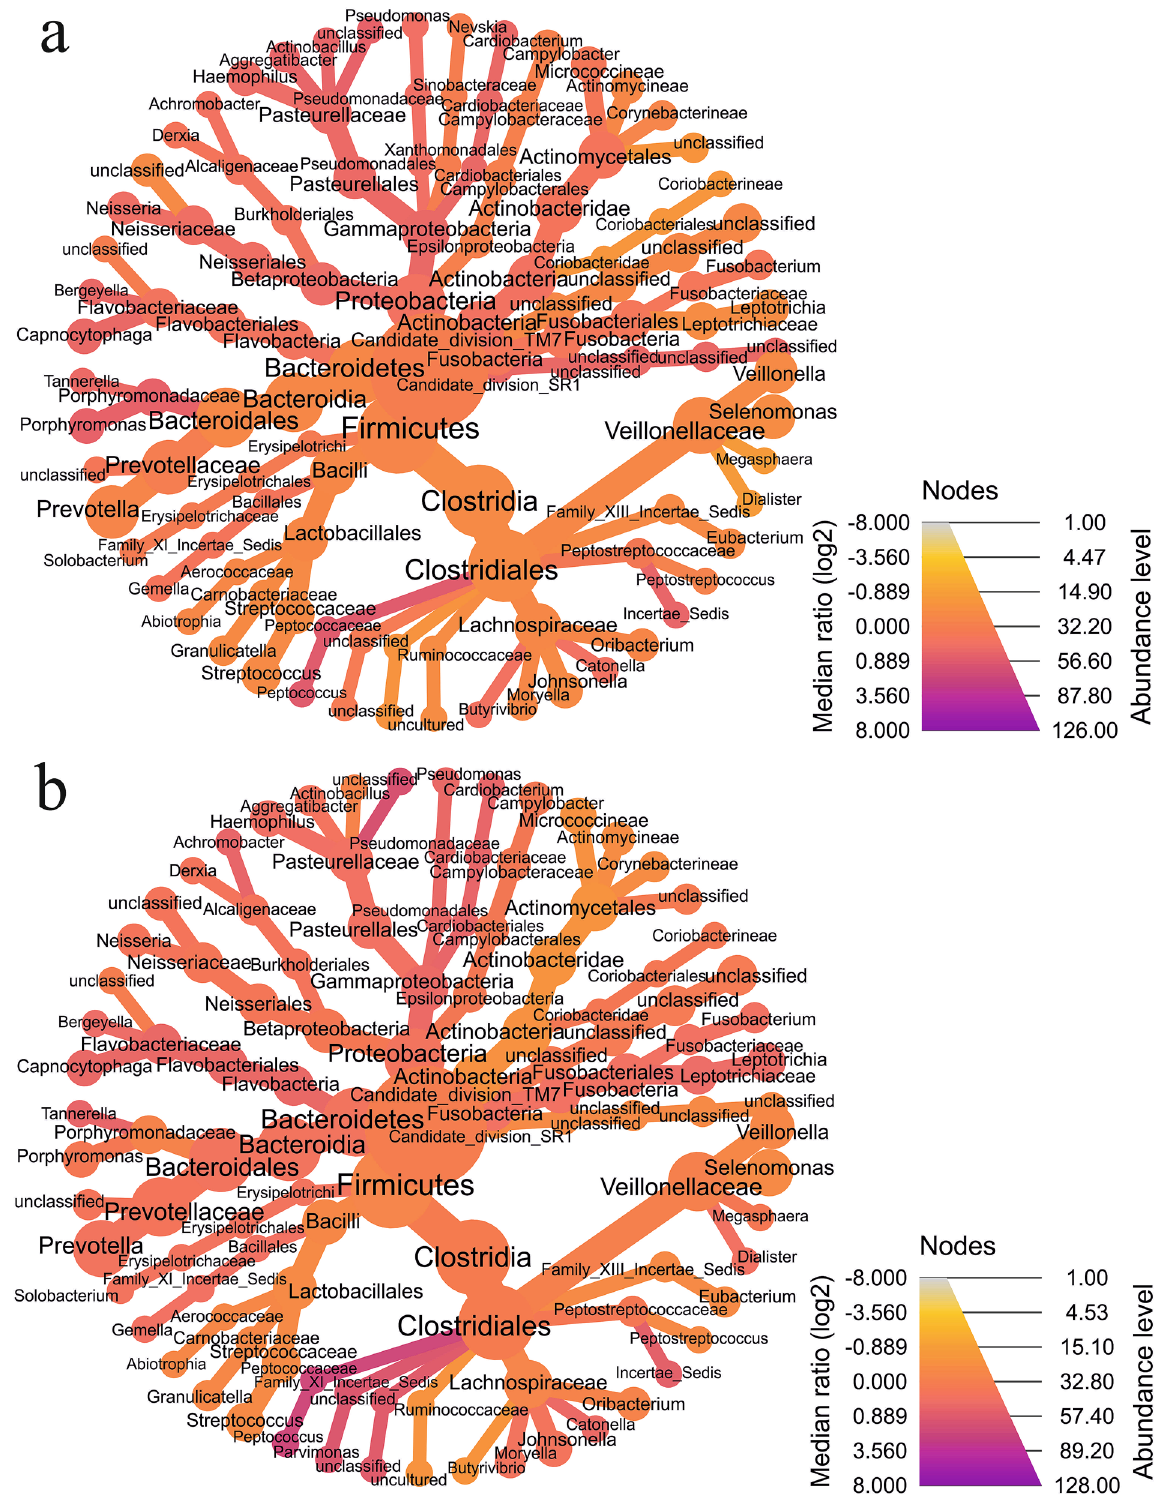
Figure 2. Heat tree analysis leverages the hierarchical structure of taxonomic classifications to quantitatively (using median abundance) and statistically (using non-parametric Wilcoxon Rank Sum test) depict taxonomic differences between microbial communities in boys ( a ) and girls ( b ). The image is drawn using web-based platform MicrobiomeAnalyst 27 (https ://www.micro biome analy st.ca/) and trees are automatically created and arranged when there are multiple roots to the taxonomy 28